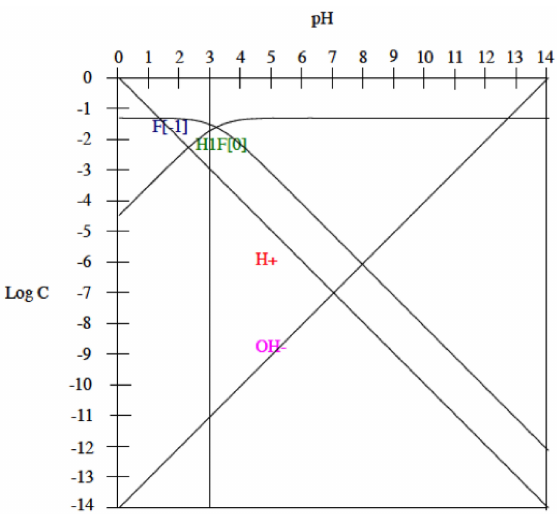
Figure 7. Equilibrium diagram of the species in the NaF solutions at different pH. Where C is the molar concentration of the